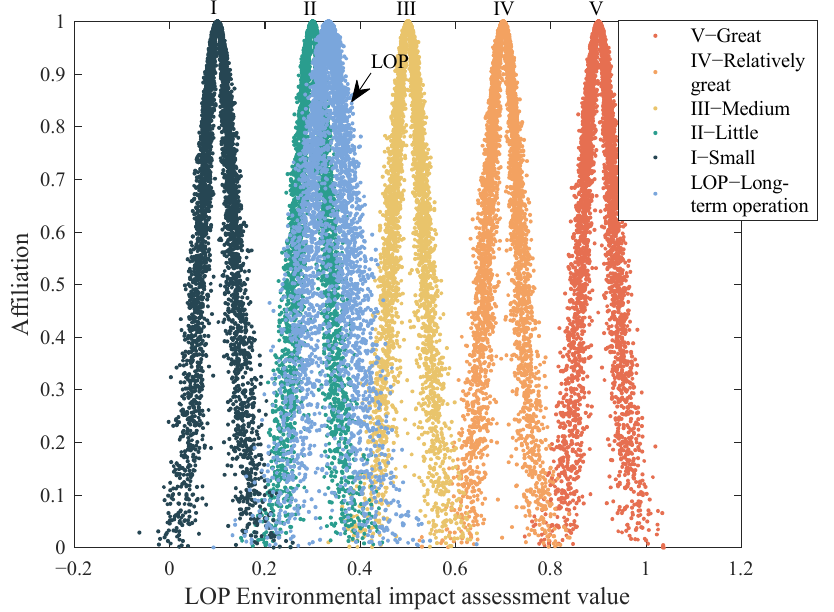
Figure 4. Cloud map for a comprehensive evaluation in the long-term operation period.